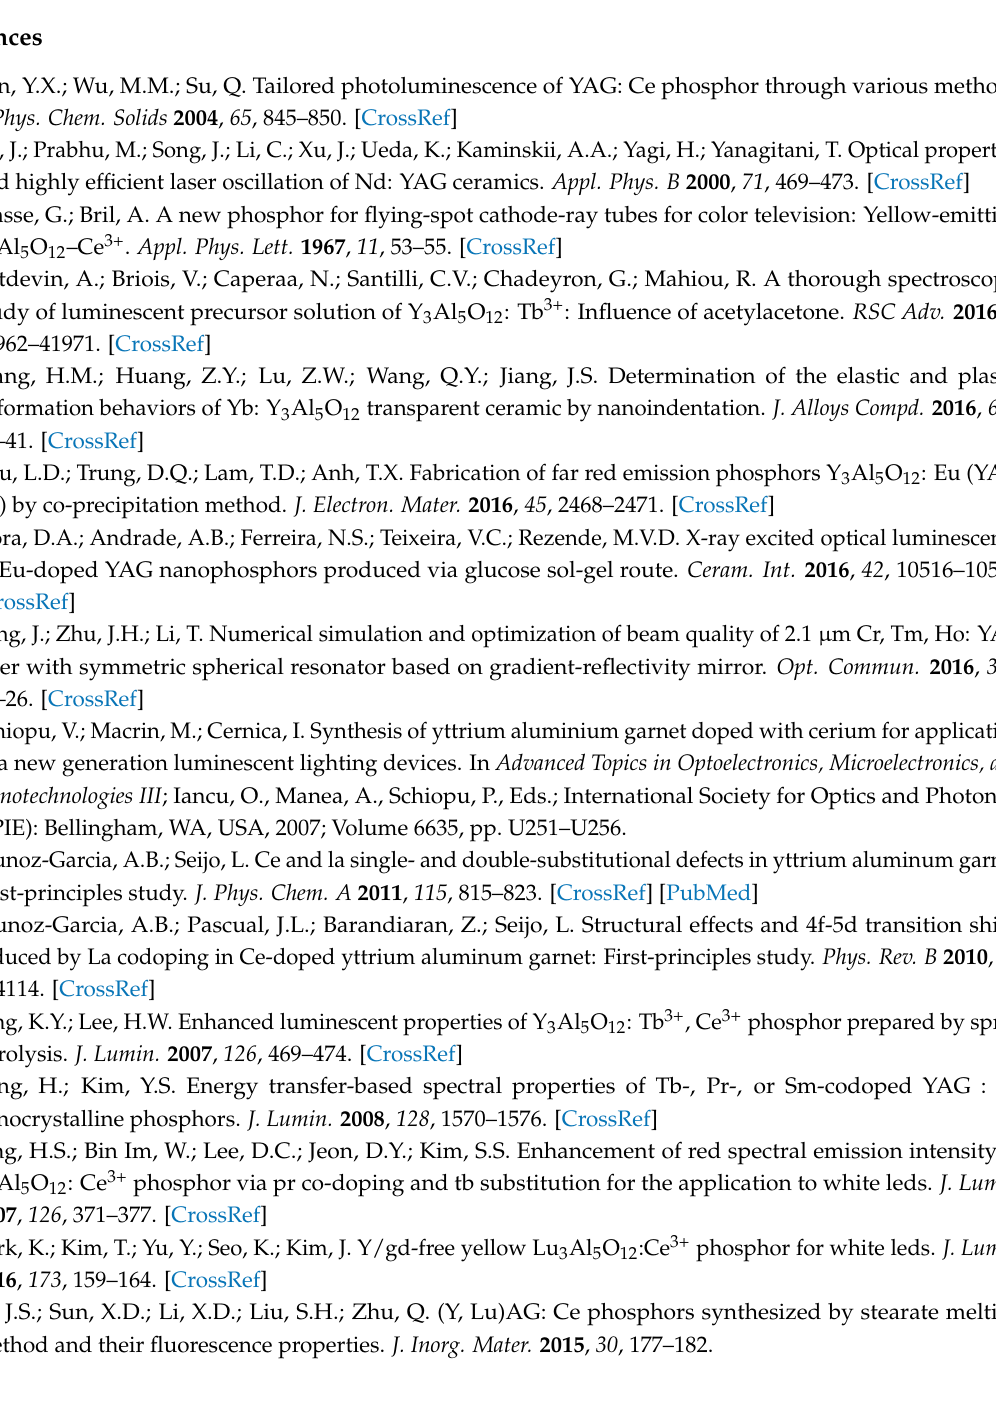
Figure S1: PLE ( λ em = 540 nm) and PL ( λ ex = 460 nm) spectra of untreated YAG:Ce 3+ , YAG:Ce 3+ -1500 ◦ C and YAG:Ce 3+ -1650 ◦ C, Figure S2: XRD patterns for untreated YAG:Ce 3+ , YAG:Ce 3+ -1500 ◦ C and YAG:Ce 3+ -1650 ◦